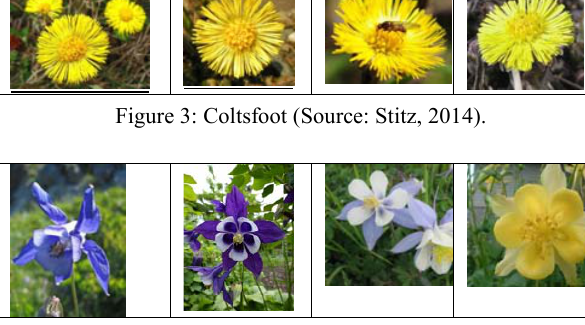
Figure 4: European columbine (Source: Stitz, 2014). The flower recognition computes probabilities from three independent probabilities (i) p(c i | I ), (ii) p(c i | d) and (iii) p (c i ) as shown in Figure 5.